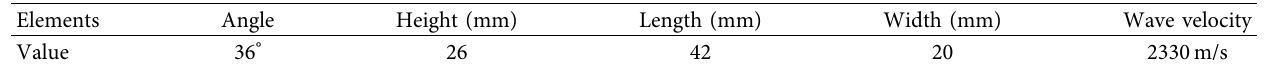
Table 2: Parameter configuration of wedge Olympus-SW55 SA11-N55S.